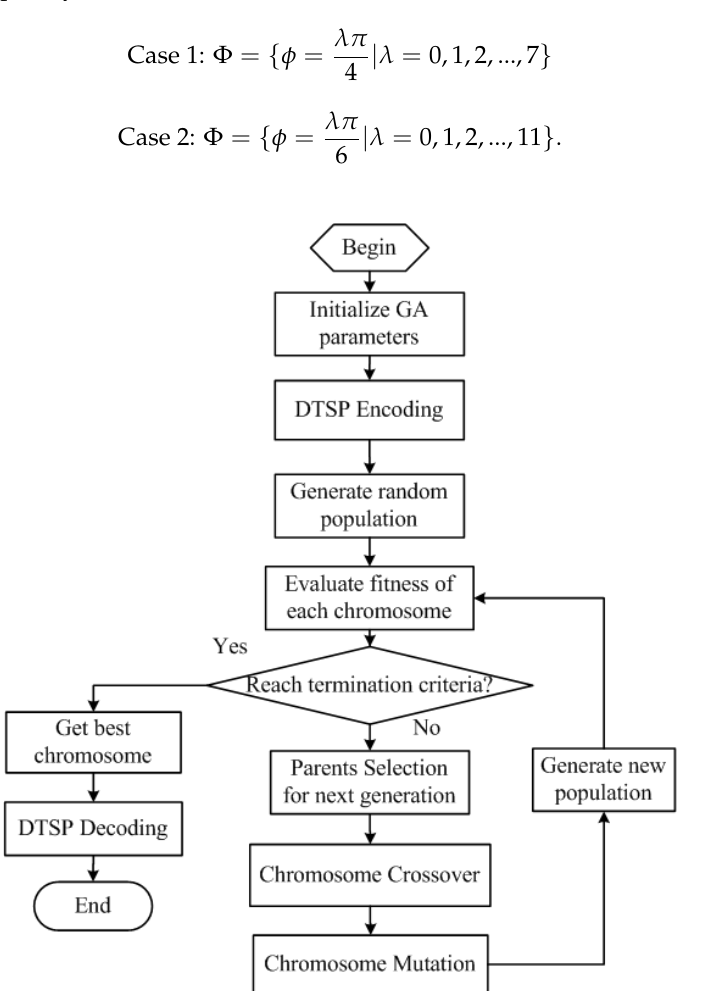
Figure 5. Genetic algorithm (GA)-based iteration